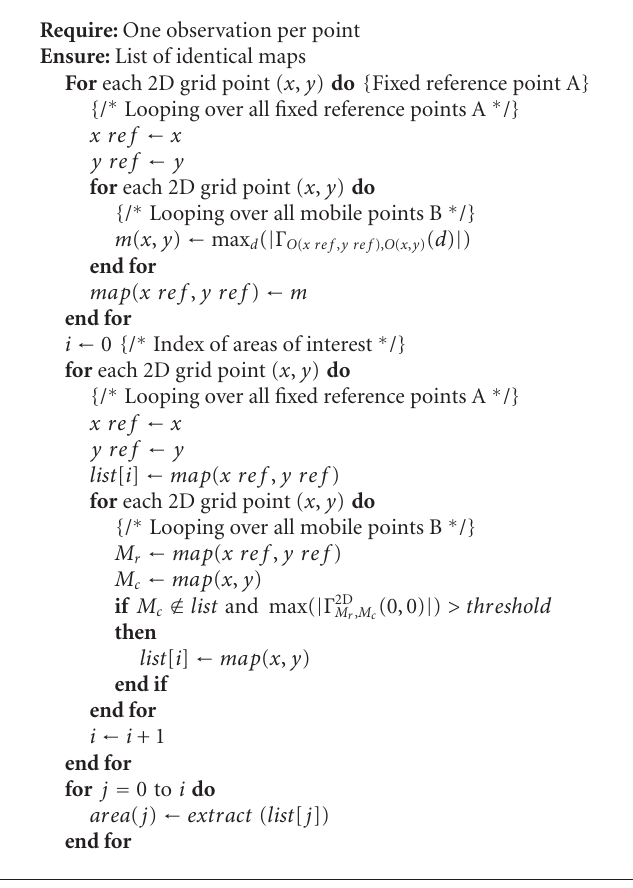
Algorithm 1: Algorithm for grouping maps per area of interest.